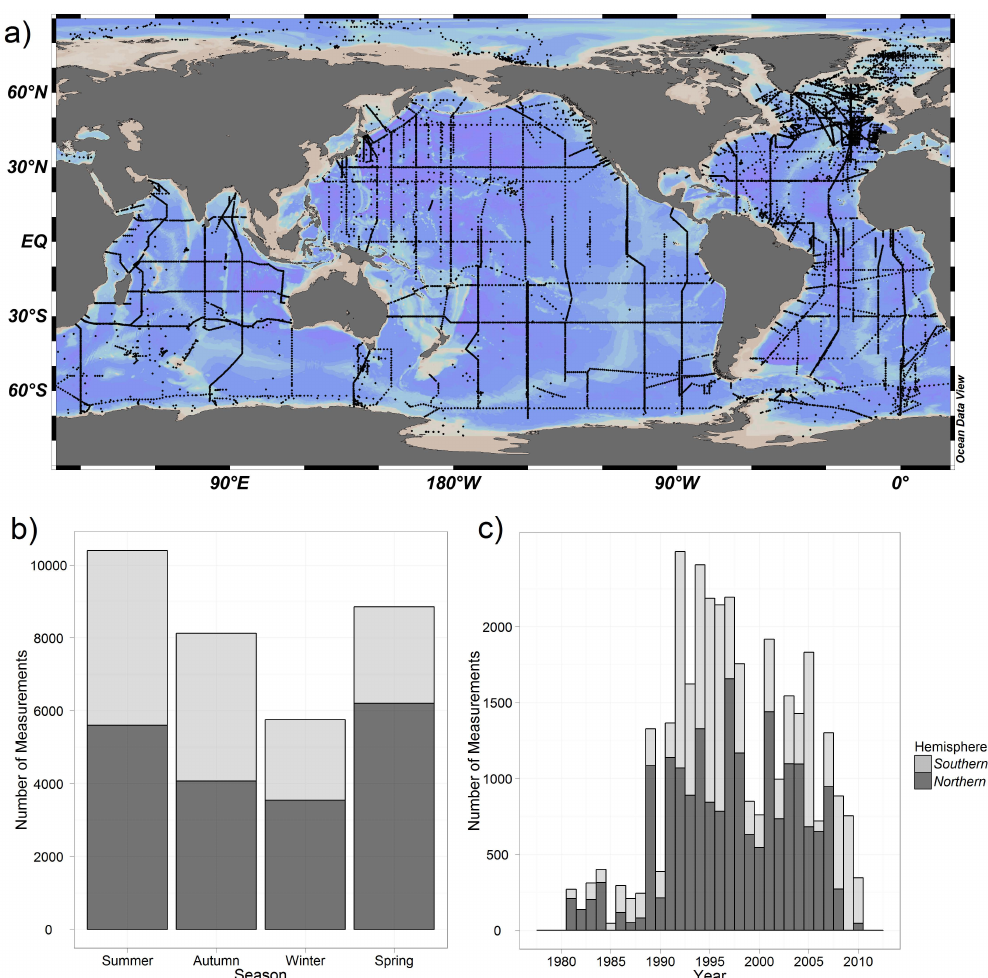
Fig. 1. (a) Global distribution of the training dataset, (b) seasonal and (c) yearly histograms of the training dataset separated into Southern (light shade) and Northern (dark shade) Hemispheres. Southern Hemisphere seasons are defined as summer (Dec–Feb), autumn (Mar–May), winter (Jun–Aug) and spring (Sept–Nov), Northern Hemisphere seasons are